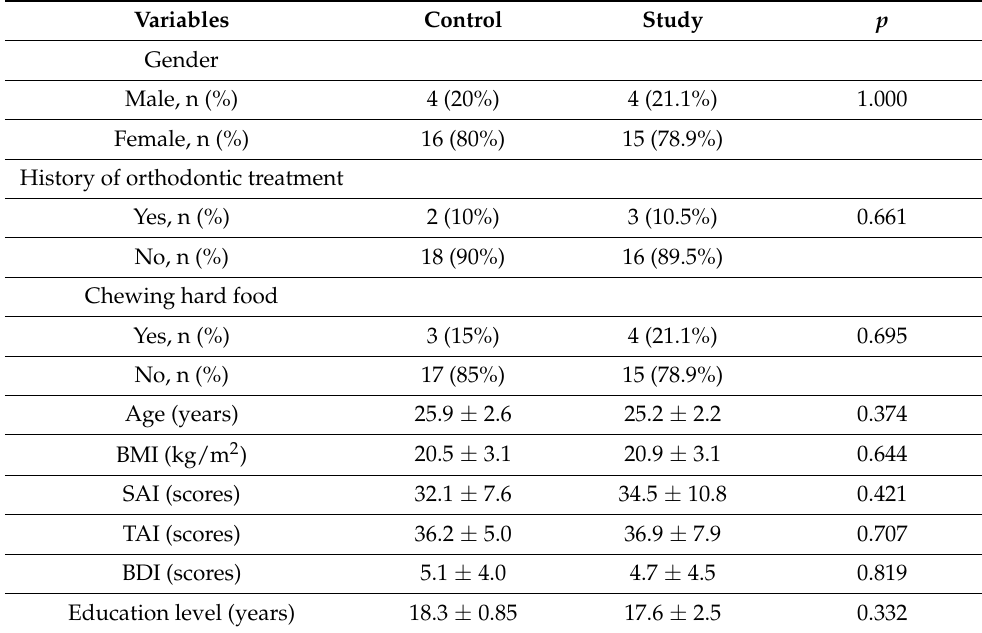
Table 2. The distribution and percentage of characteristics, anxiety and depression levels, and oral habits in the study and the control